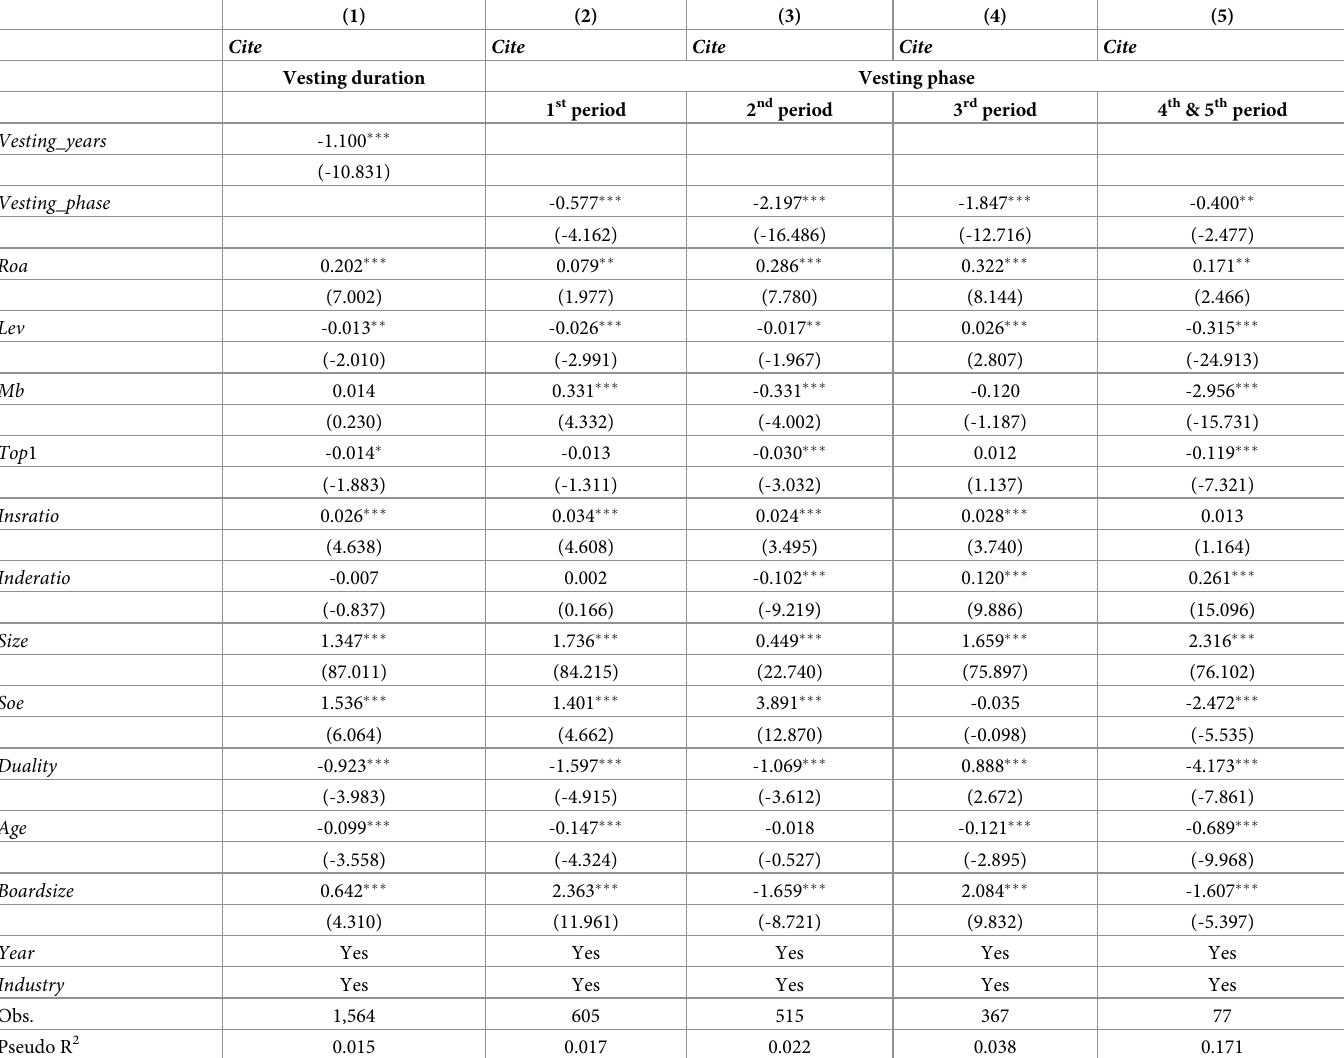
Table 2. Vesting periods and exploratory innovation strategy intensity: Cross-sectional